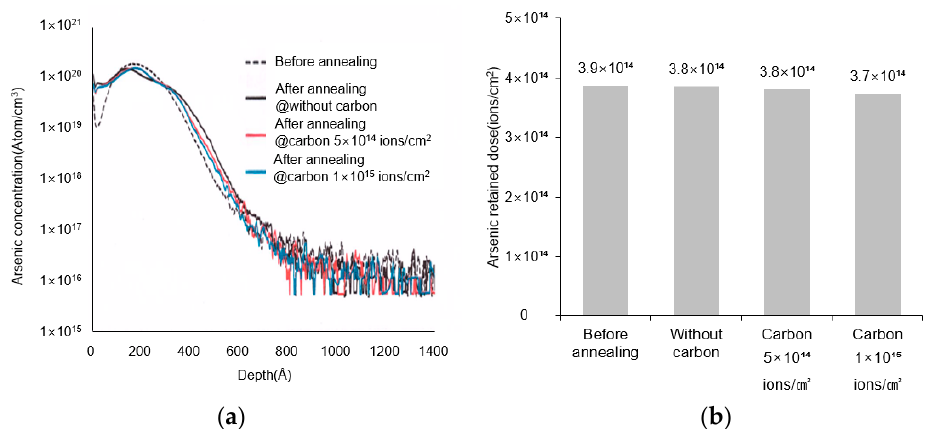
Figure 5. ( a ) SIMS profile of arsenic concentration after carbon implantation before and after annealing process. ( b ) Retained dose of fluorine in the wafer.